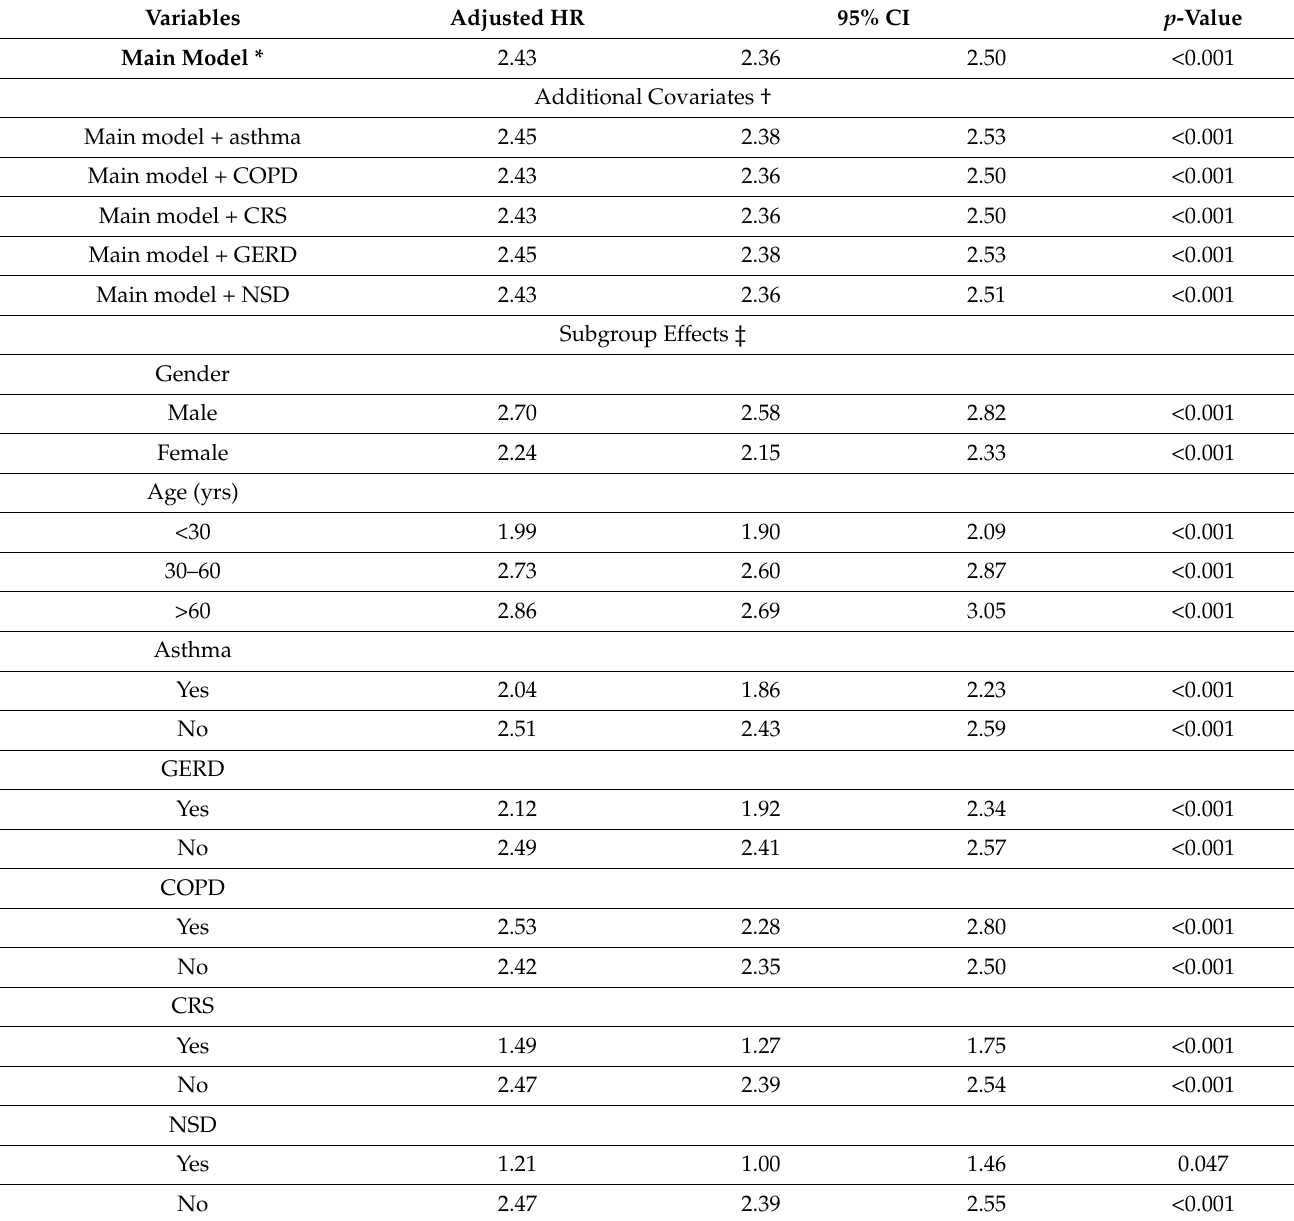
Table 2. Associationsbetweenallergicrhinitisandriskoflaryngealpathology(multivariableCoxproportionalhazardsregression).